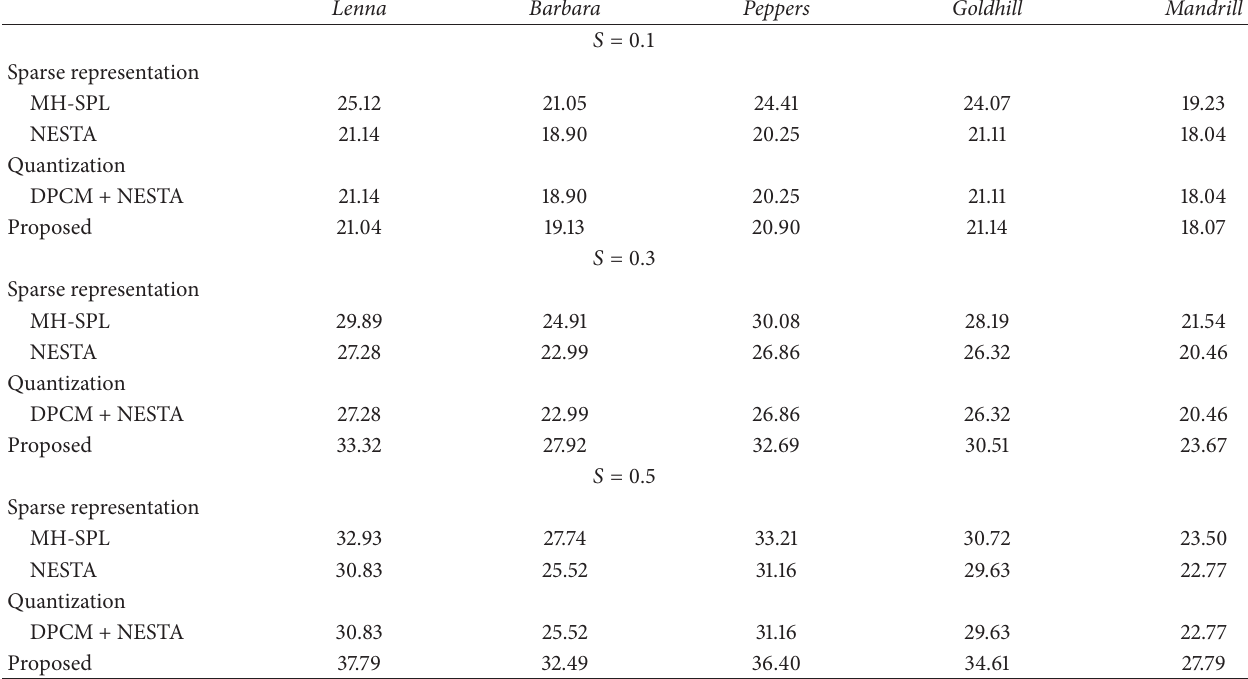
Table 1: Comparison of PSNRs (dB) reconstructed images when using different algorithms. Lenna Barbara Peppers Goldhill Mandrill 𝑆 =